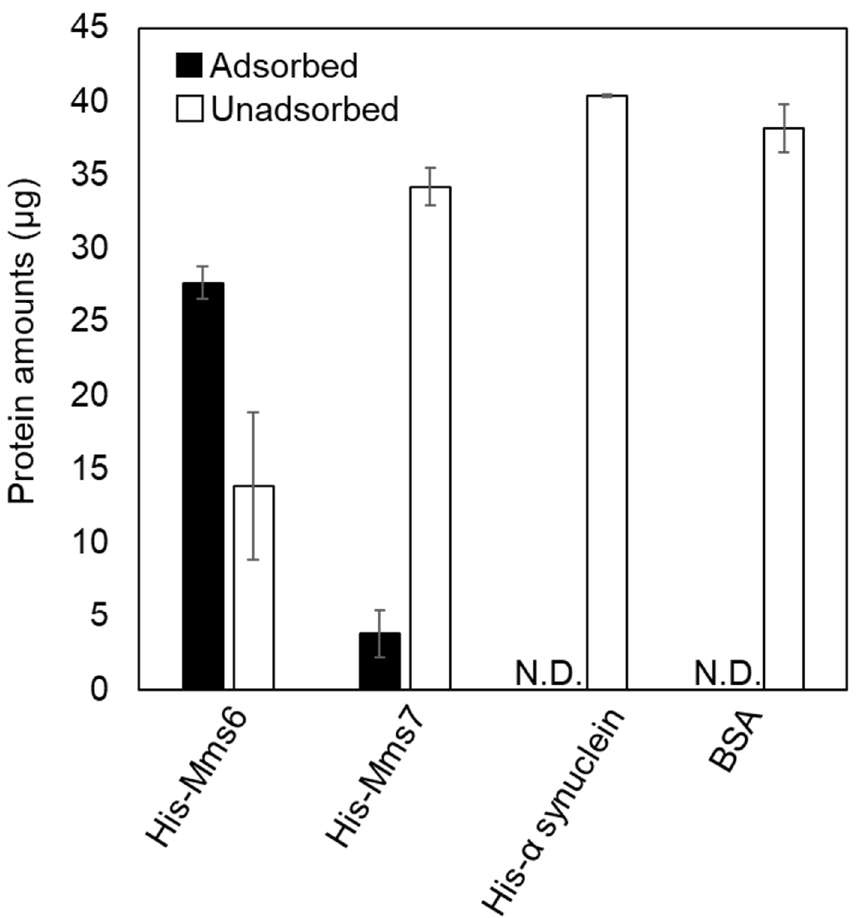
Figure 2. The adsorption assay of different proteins on magnetite nanoparticles. Adsorbed (black bar) or unadsorbed (white bar) protein amounts of His-Mms6, His-Mms7, His-α synuclein, BSA, cytochrome c , and lysozyme. A solution containing 40 µg of protein was added to 2.5 mg of the particles. N.D.: not detected.